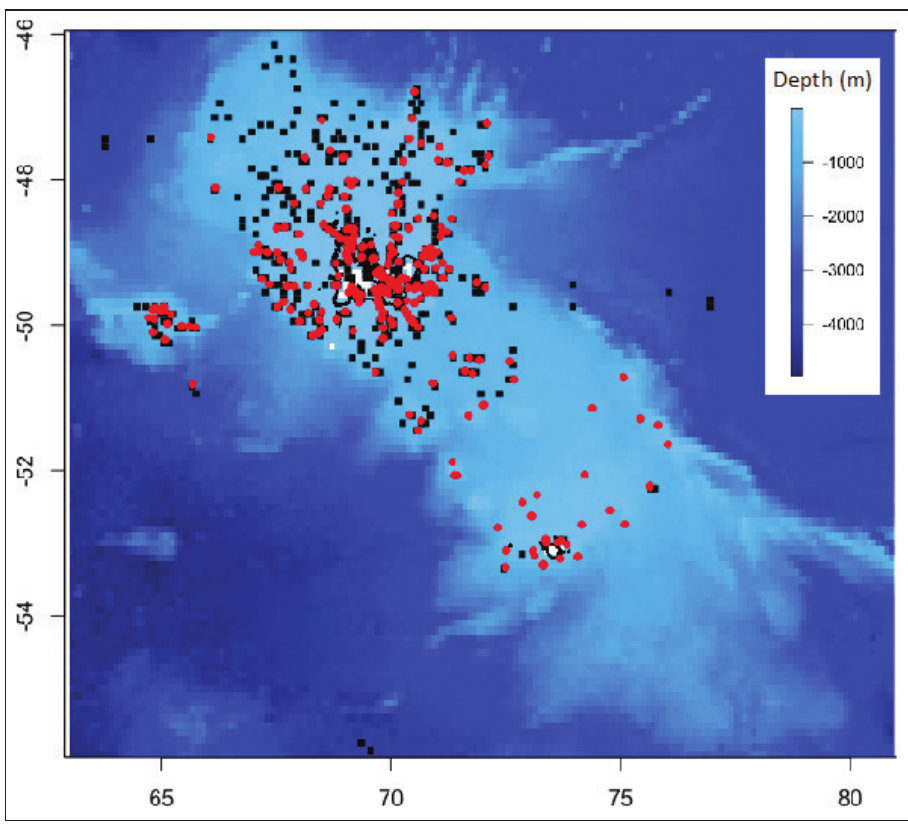
Figure 1. Sampling effort. Red dots depict echinoid occurrences. Black squares correspond to visited sites at which no echinoid was